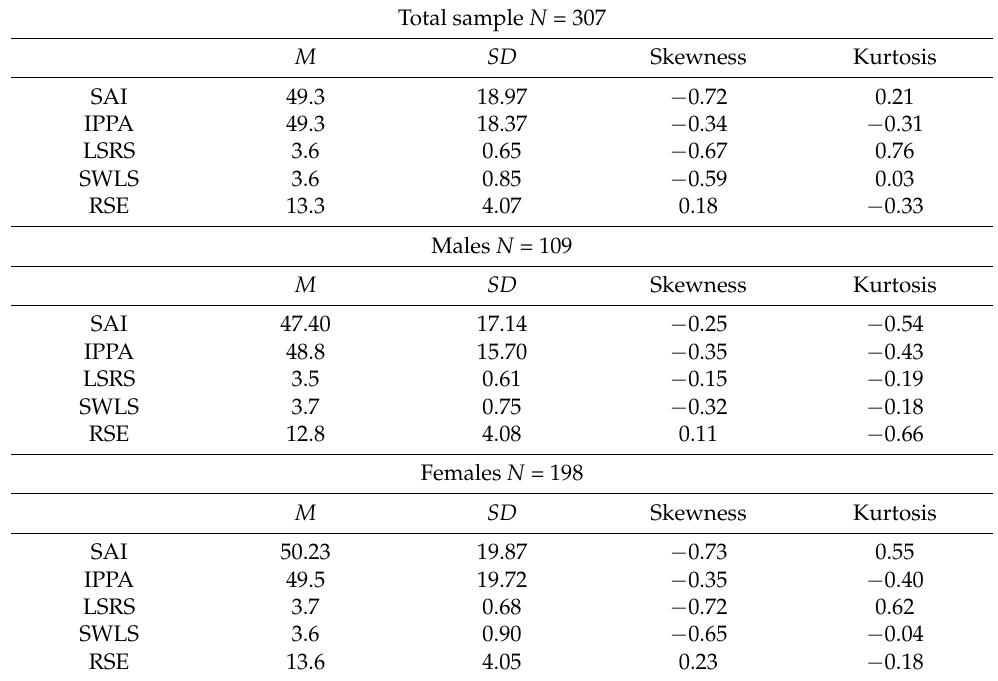
Table 4. Descriptive Statistics for the IPPA (Parent Form), the SAI, the LSRS, the SWLS, and the RSE ( N =